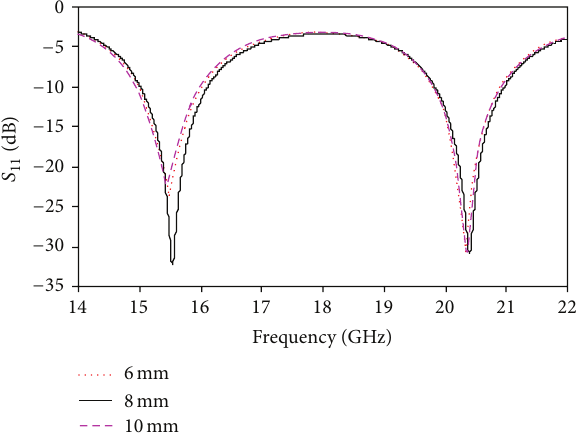
Figure 3: Simulated return loss for different values of 𝐿 1 .